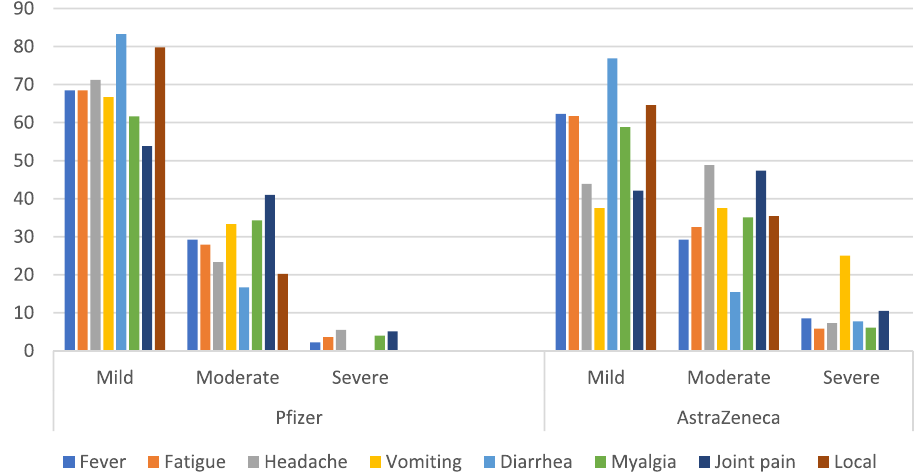
Figure 2. Severity of systemic and local adverse events of both studied vaccines among vaccinated